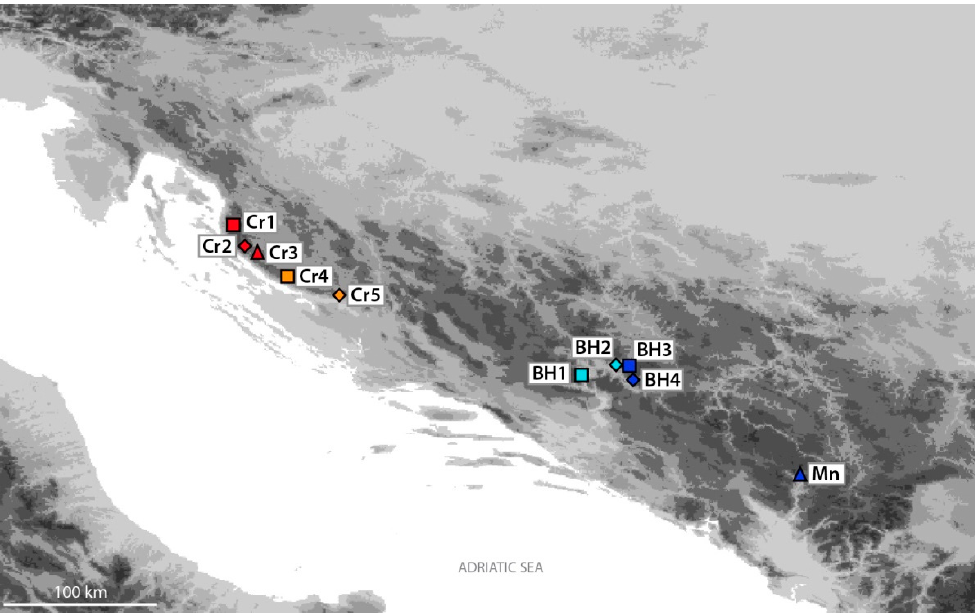
Figure 2. Collection sites of studied Micromeria croatica populations from Croatia (Cr1–Cr5), Bosnia and Herzegovina (BH1–BH4), and Montenegro (Mn).